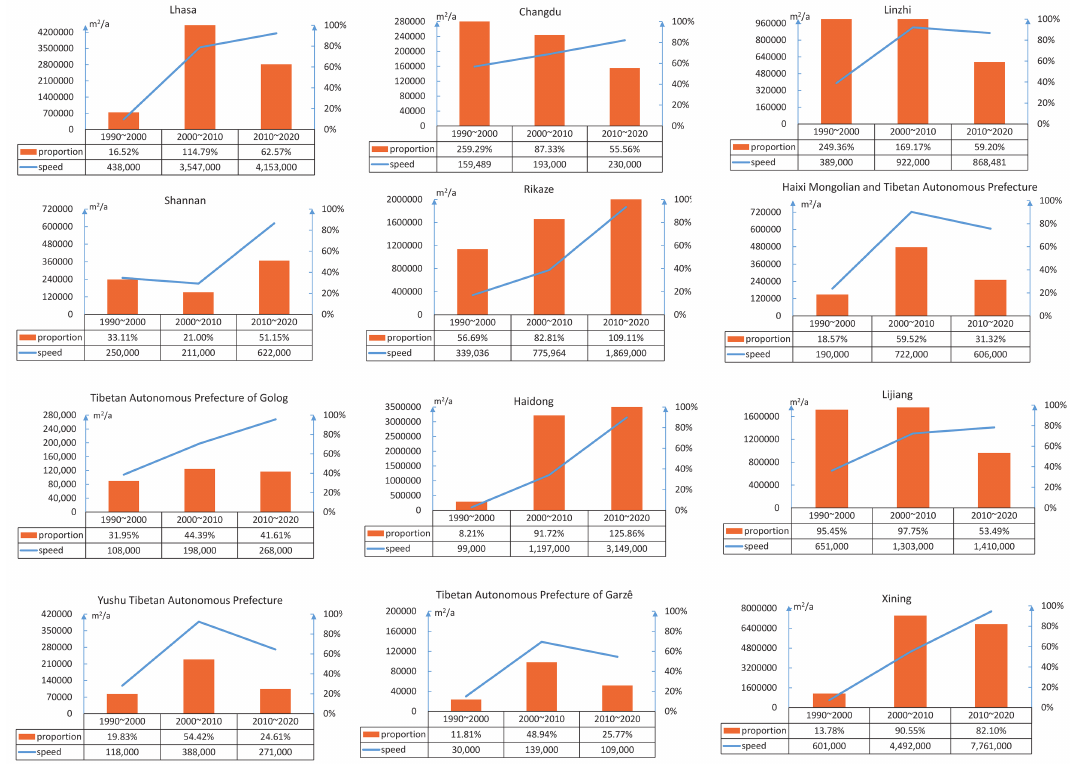
Figure 4. Urban expansion speed and proportion in a municipal